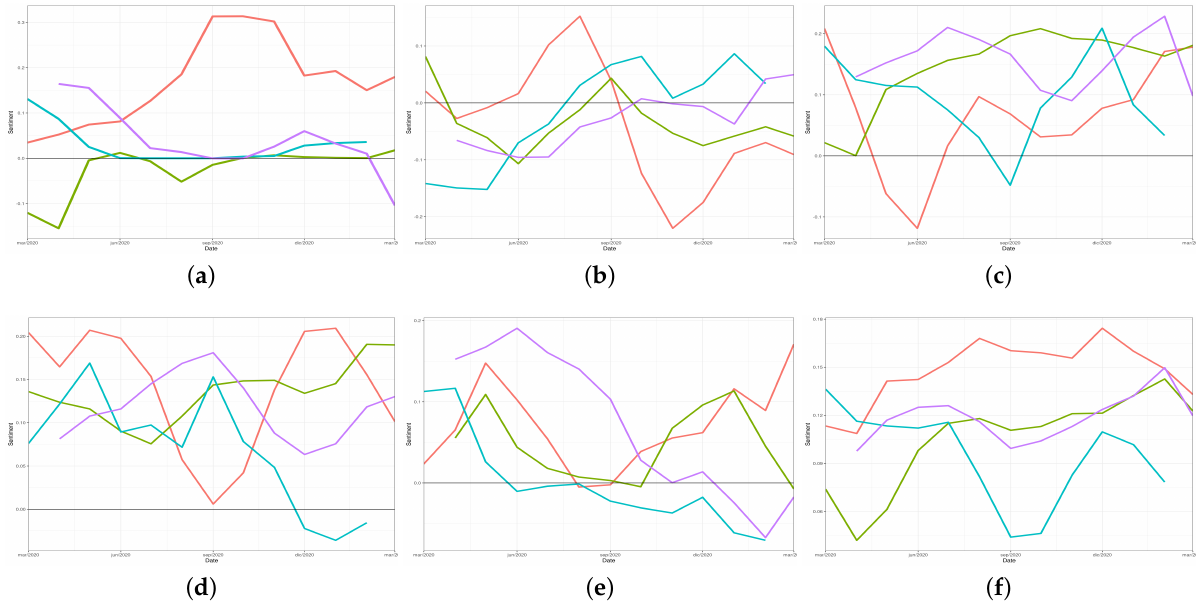
Figure 4. Sentiment evolution of words related to different topics per country: Chile in red, Mexico in green, Peru in blue, and Spain in purple: ( a ) democracy; ( b ) depression; ( c ) recovery; ( d ) meeting; ( e ) face mask; and ( f )